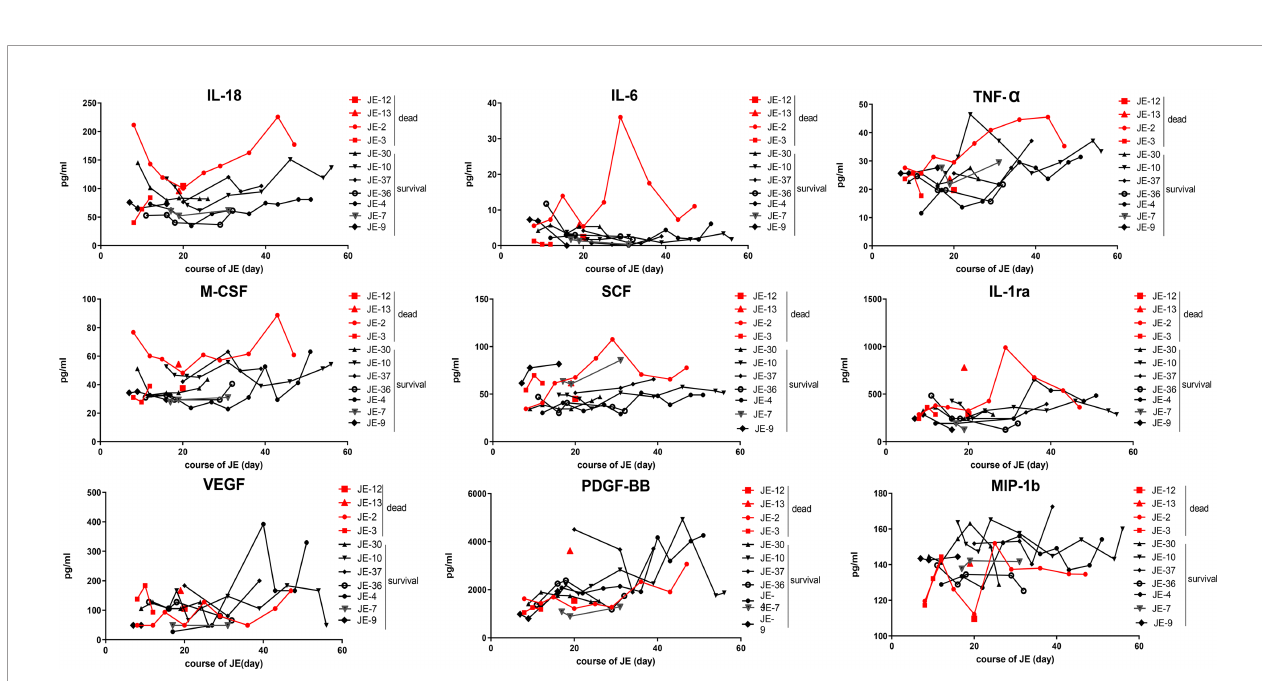
FIGURE 4 | Dynamic changes of some main cytokines in severe survived patients or not. Series of cytokines in the plasma from severe patients without de fi nite nosocomial bacterial infection (four survived cases, seven fatal cases) were monitored continually, and the course of JE was calculated from the onset day of symptoms such as fever and headache according to the